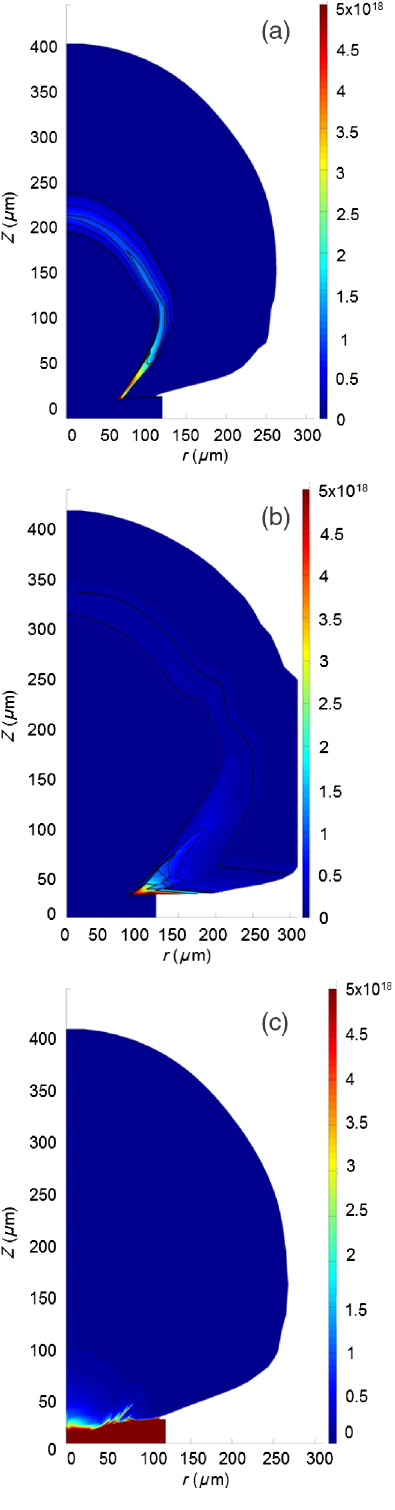
FIG. 2. 2D PALE hydrodynamic simulations of the boron- plasma expansion after the action of the laser pulse (in the range 1 – 1.85 ns) for (a) the B layer implanted in the SiH substrate, (b) the B layer deposited on the SiH substrate, and (c) the B layer diffused in the SiH substrate. The gradient scale on the right-hand side shows the B-plasma